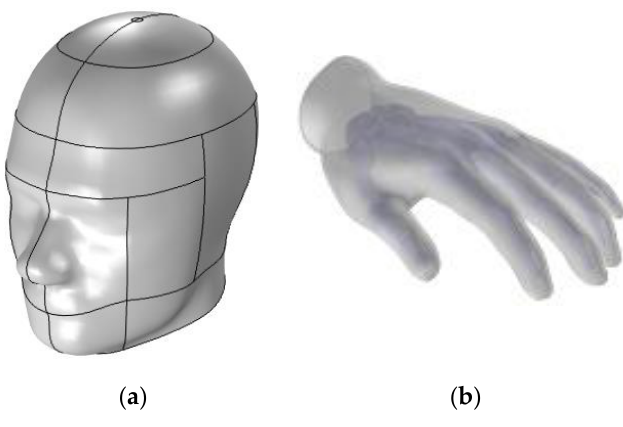
Figure 3. ( a ) Modeled head; ( b ) Modeled hand. Table 2. Dielectric properties of the skin and bones of the hand at 30 kHz and 100